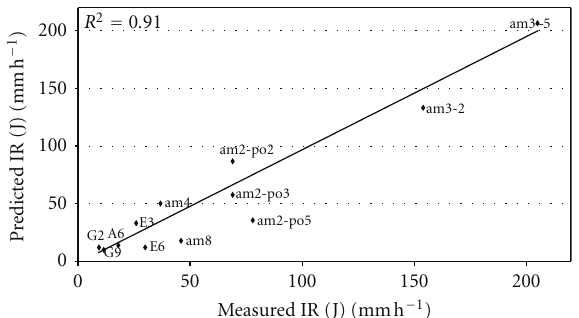
Figure 5: ANN results for the test set ( N = 11 samples; same sam- ples were used for PLS